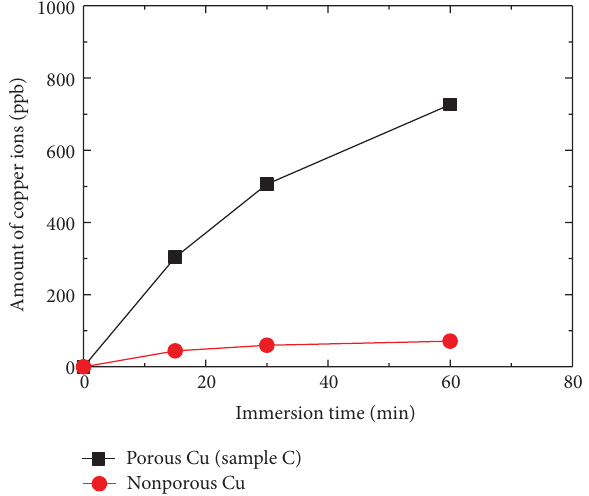
Figure 3: Number of dissolved copper ions in distilled water after immersing the nonporous and lotus-type porous copper samples for various time